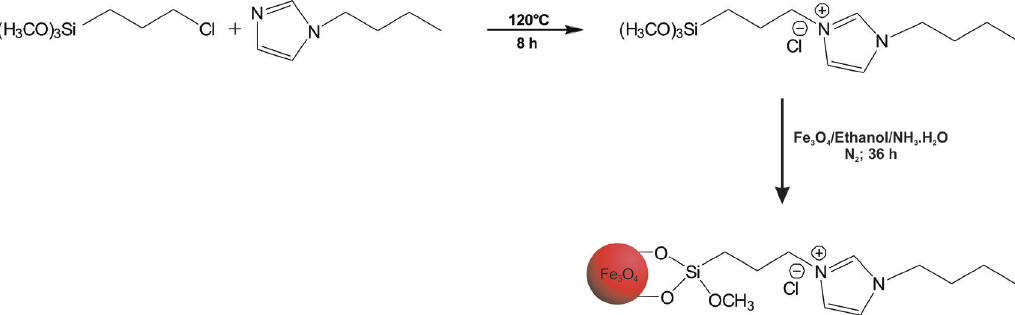
Figure 7 Preparation of magnetite NP functionalized with ionic